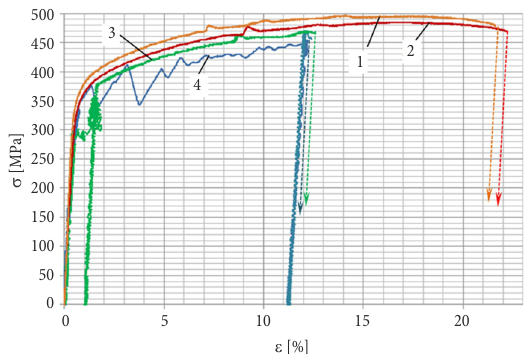
Fig. 4. Stress–strain curve of aluminum alloy 2024-T3: 1 – ST at 20ºС; 2 – HLN, warming up to 20ºС + ST; 3 – ST + DNP ( F imp =90.4 kN), HLN, warming up to 20ºС + ST; 4 – ST + DNP ( F imp =111.8 kN), HLN, warming up to 20ºС +